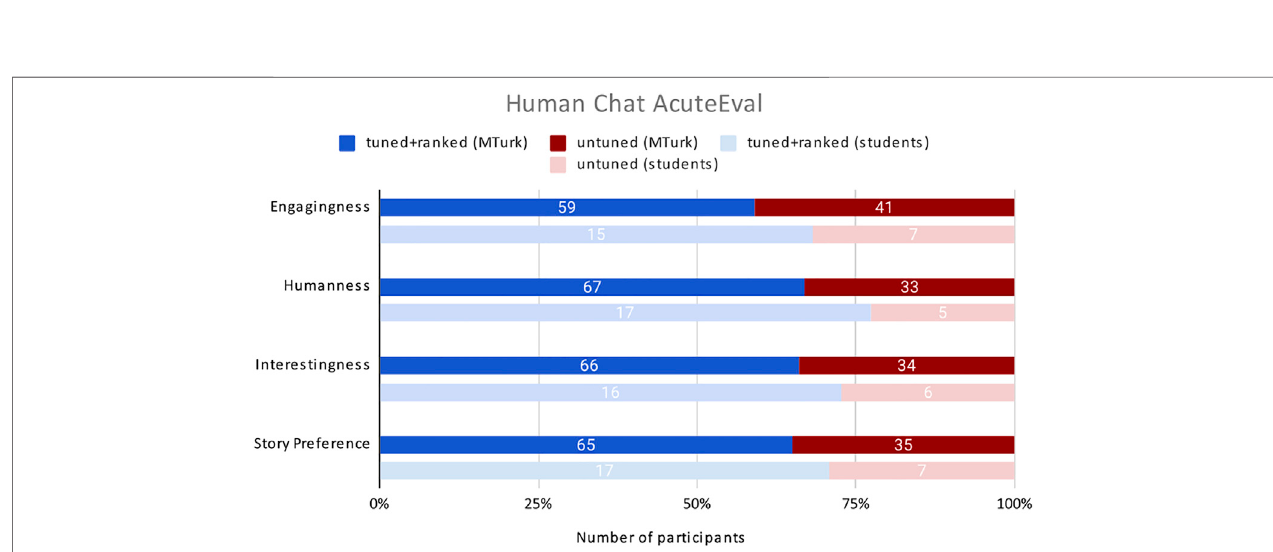
Frontiers in Computer Science |